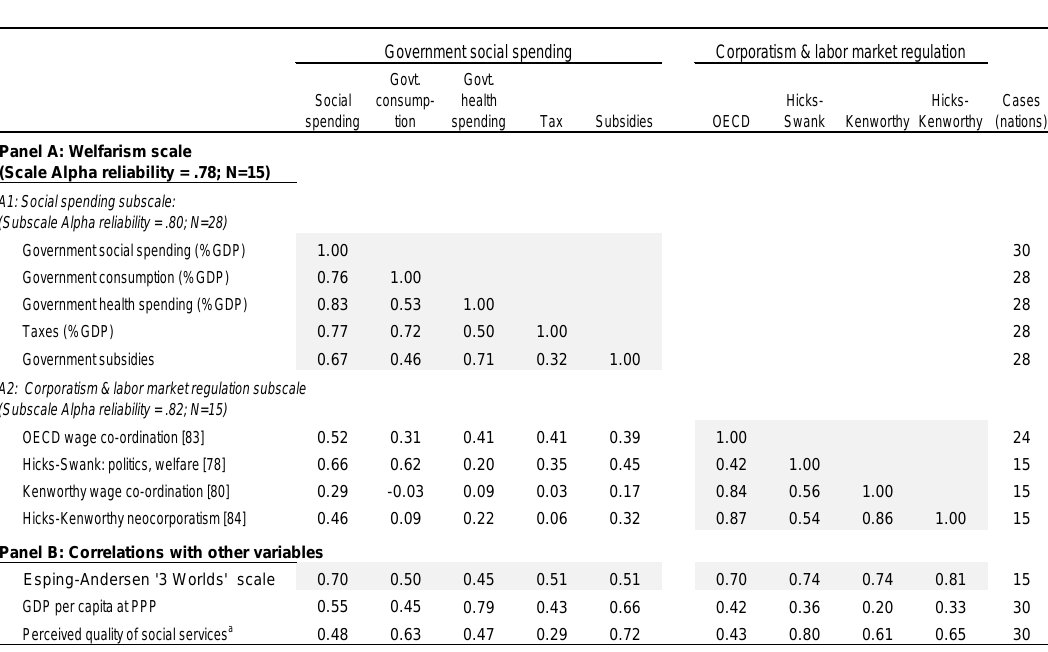
Figure 2. Measurement of welfarism: Scale combining government social spending and corporatist labor market policies. Correlations (pairwise-present). 30 never-Communist societies,